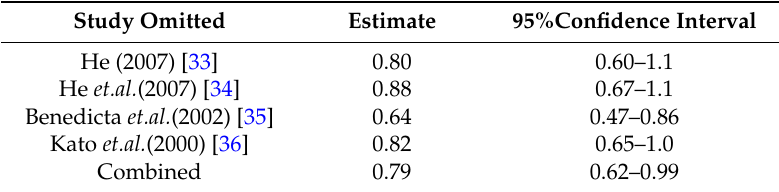
Table 7. Sensitivity analysis of T1766C polymorphism and EH (TC vs.